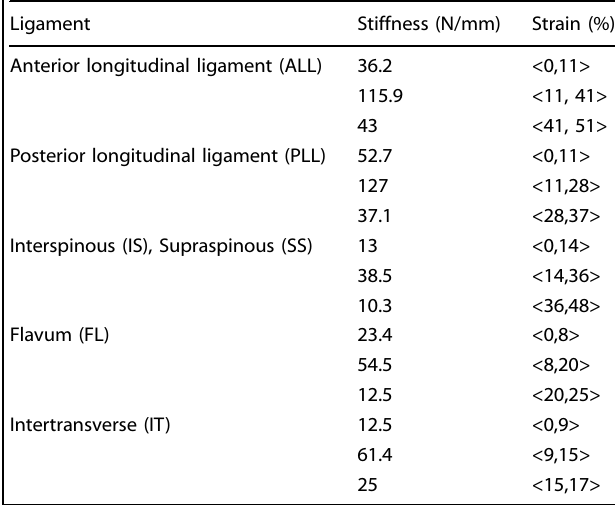
Table 3. Ligament stiffness values in the